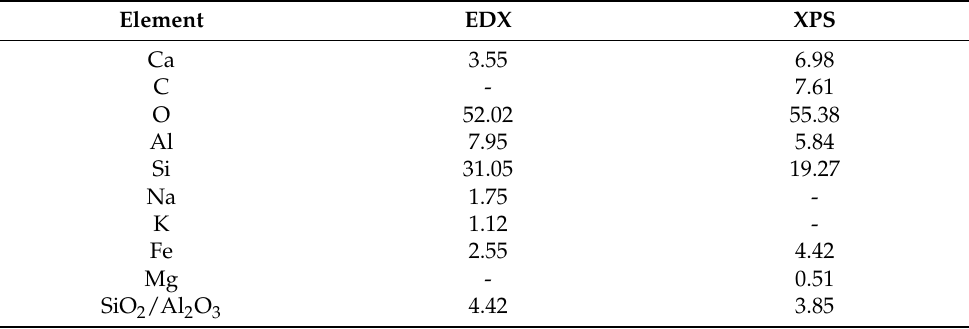
Table 4. Element composition and Si/Al Ratio of the natural zeolite (XPS, EDX).